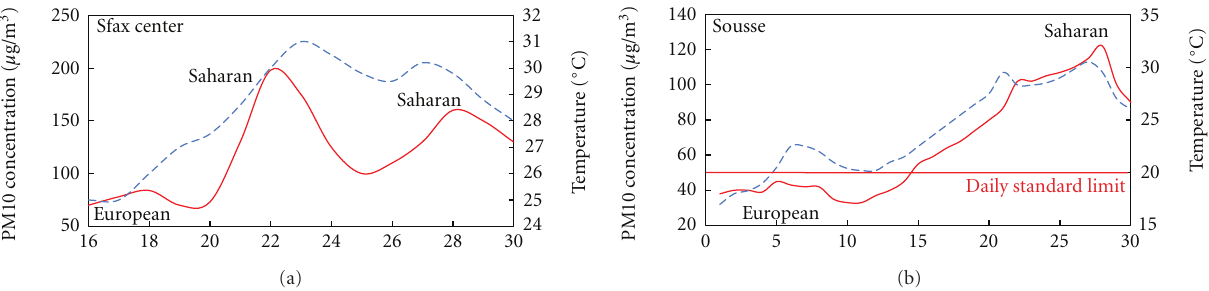
Figure 8: Daily variability of the PM10 concentrations and temperature during summer in the selected monitoring stations. Time evolution of the left y axis is plotted with solid line, and the right one is plotted with dashed line. (Solid and dashed lines are smooth curve fits).